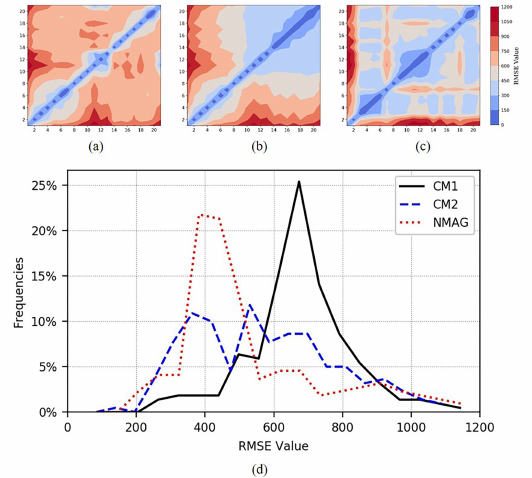
Figure 9. The error matrices and the frequency distribution curve of the root mean square error (RMSE) for the normalized results obtained using NMAG and two contrasting methods (refered as Contrast Method 1 (CM1) and Contrast Method 2 (CM2)). As the color transitions from blue to red, the radiometric distortion increases. The error matrices of RMSE obtained using ( a ) CM1, ( b ) CM2, and ( c ) NMAG. ( d ) The frequency distribution curve of RMSE obtained using NMAG and two constrasting